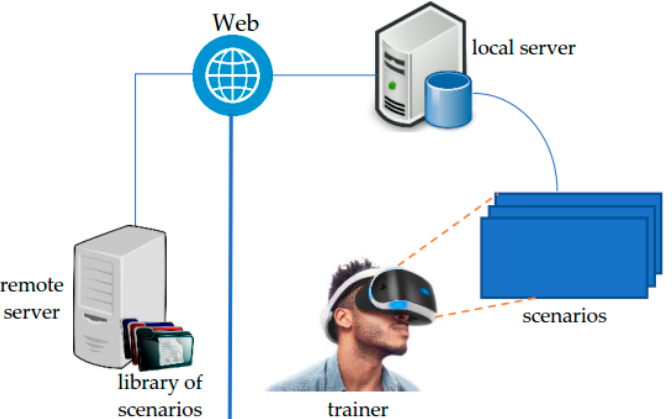
Figure 7. Tools and their connections for producing virtual reality (VR) training scenarios.